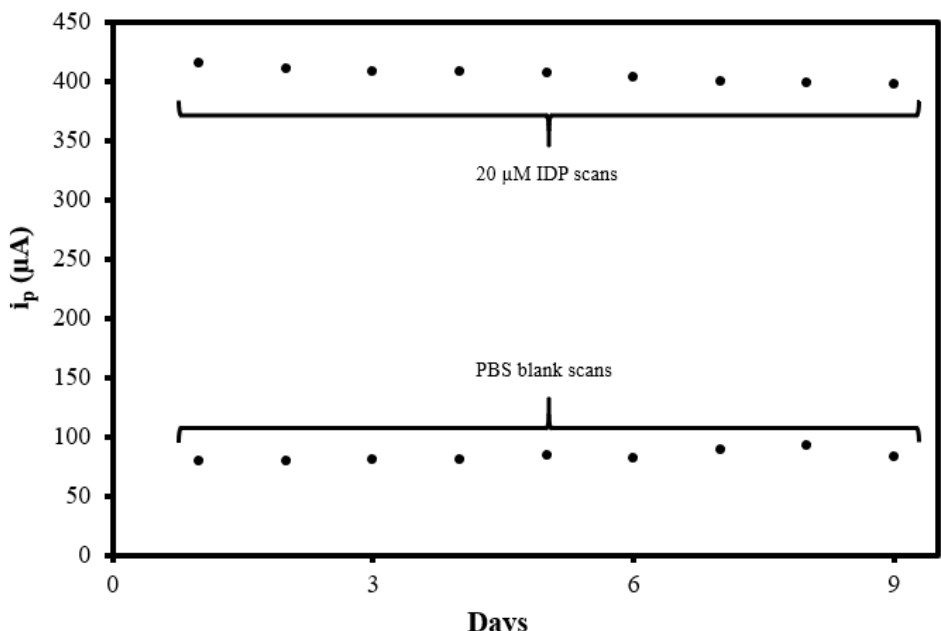
Figure 10. Summative peak DPV current measurement (i p ) vs. days from the MIP@CNT/CNC MN sensor reusability test.